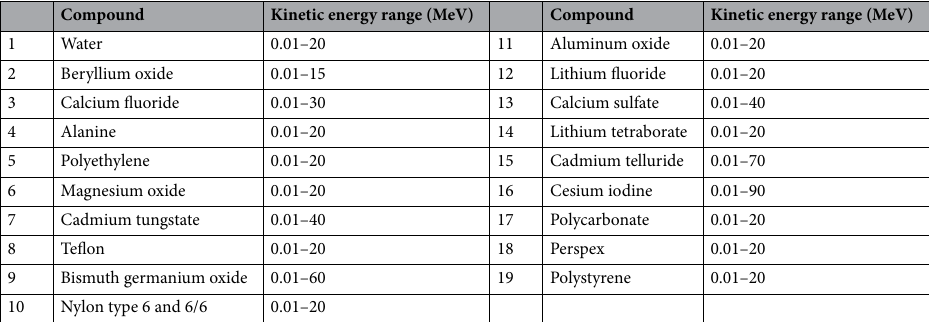
Table 2. Valid kinetic energy range for electron